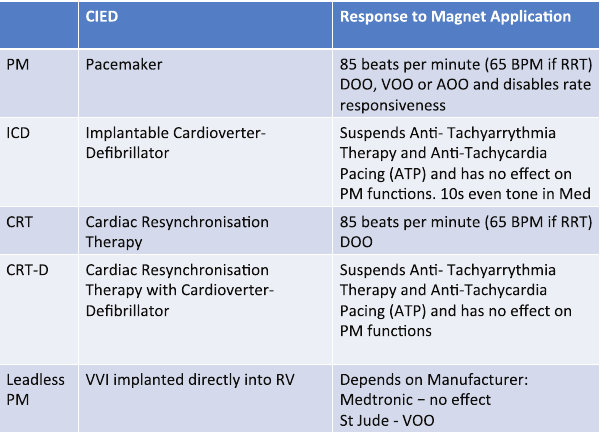
Figure 6: Operating Theatre Requirements PM-on or CRT-P-on protocol